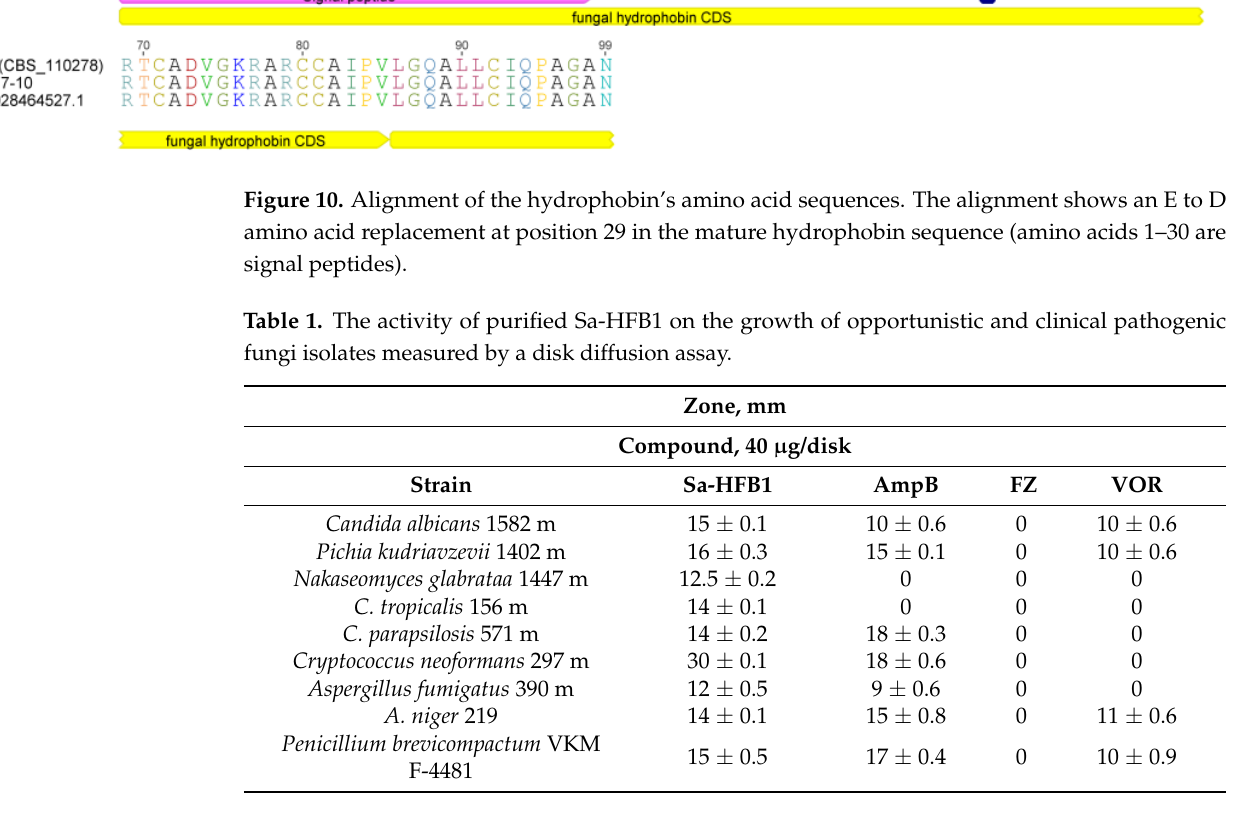
Figure 9. Alignment of hydrophobin DNA sequences. The alignment shows single-nucleotide polymorphisms (SNPs) in the S. alkalinus 8KS17-10 strain. An exon substitution is marked by blue highlighting, and an intron SNP by red highlighting. The S. alkalinus 8KS17-10 strain sequences of the hydrophobin gene (NCBI ID ON149453) contained two substitutions: The substitution of C to A at the 369 position was in an intron, although it did not alter the amino acid sequence. The other, a G to C